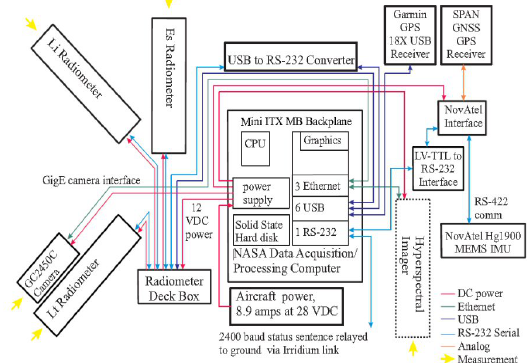
Figure 2. Block diagram of OCEANIA payload